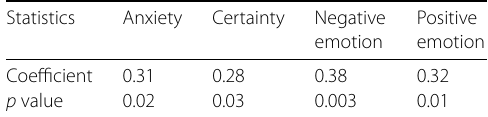
Table 3 Correlation statistics between LIWC-generated and hand-coded psychological scores for 100 political extremist-written